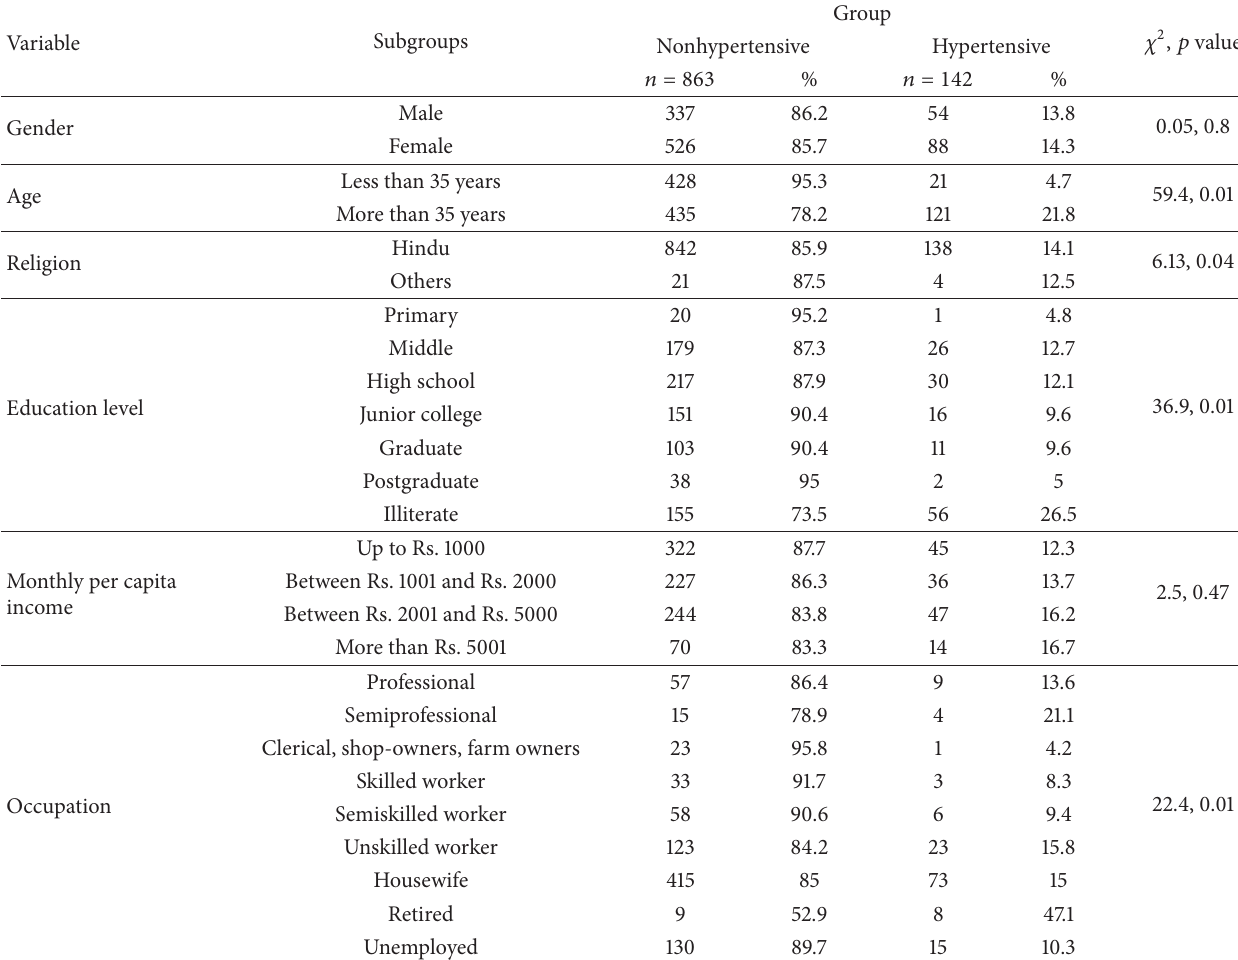
Table 1: Sociodemographic characteristics of the study